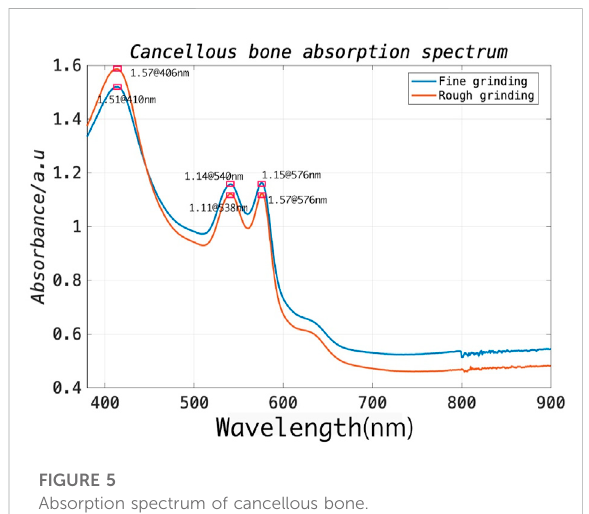
FIGURE 5 Absorption spectrum of cancellous bone.